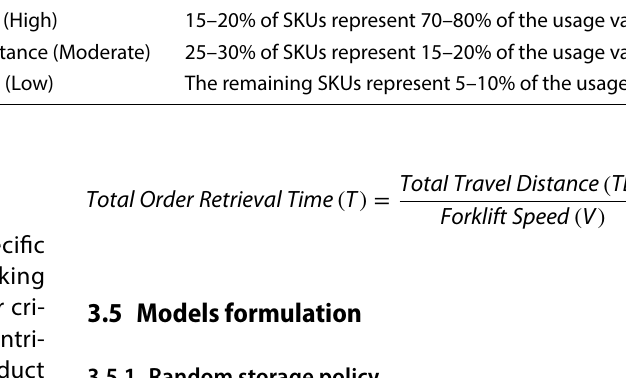
Table 2 Products classification rules based on ABC analysis